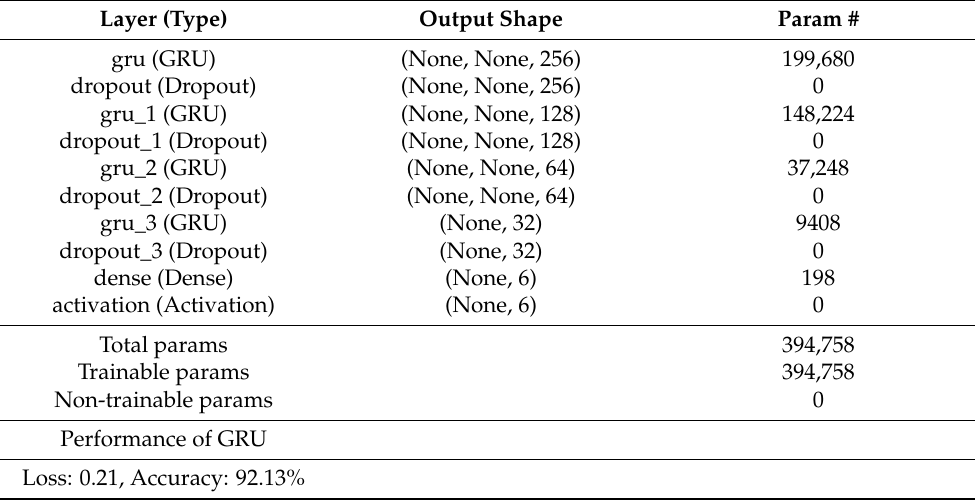
Table 3. Summary of model parameters based on fine-tuned GRU neural network.